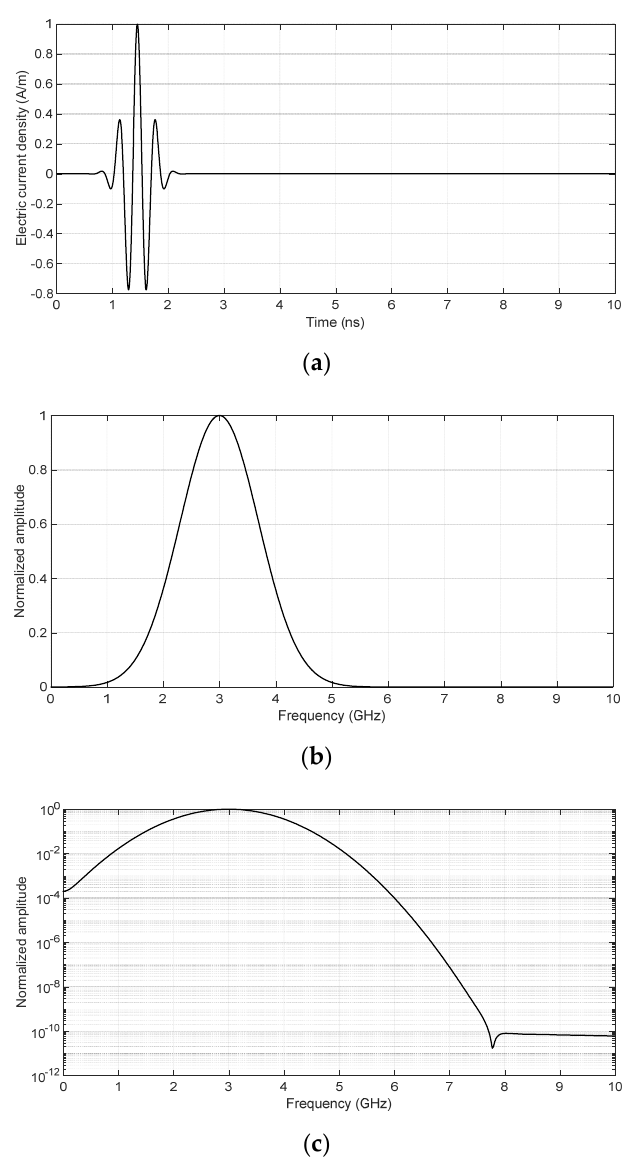
Figure 3. The cosine-modulated Gaussian pulse used as the PD source: ( a ) time-domain waveform; ( b ) magnitude spectrum in linear scale; ( c ) magnitude spectrum in logarithmic scale. For the 2D simulations, five case studies (CS#1 to CS#5) are considered with different locations of the source and the sensor (see Table 1). In the first and second case studies, the windings (see Figure 2) are not included in the model. Table 1. The list of case studies in the 2D simulations.